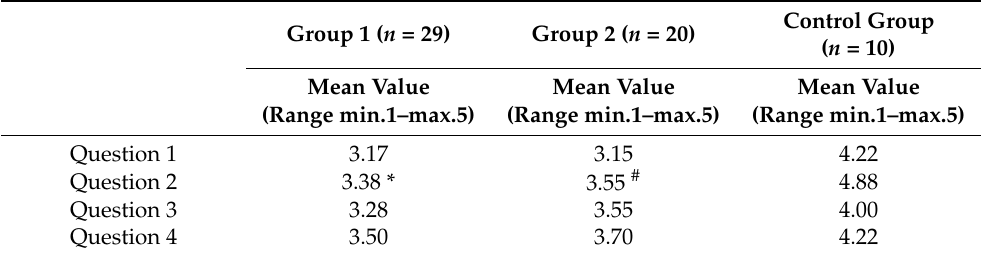
Table 1. The mean values and median parameters (scale 1–5) of the subjective parameters of questions 1–4 with no significances in Mann Whitney U -test between the groups for p = 0.048; p = 0.012